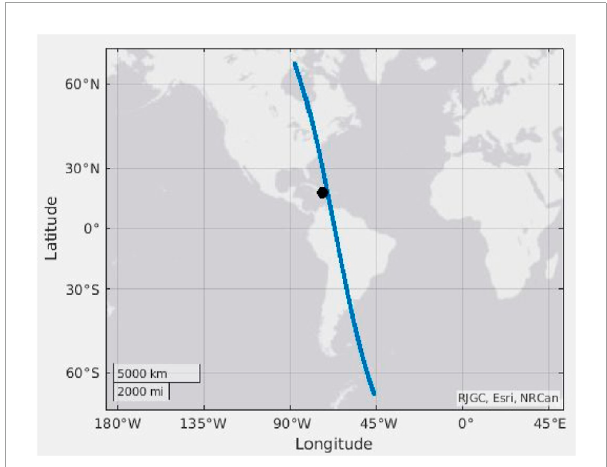
FIGURE 6 CSES-01 orbit (blue line) flying over the EE on 14 August 2021, 6 h before the earthquake. The black point represents the EE.